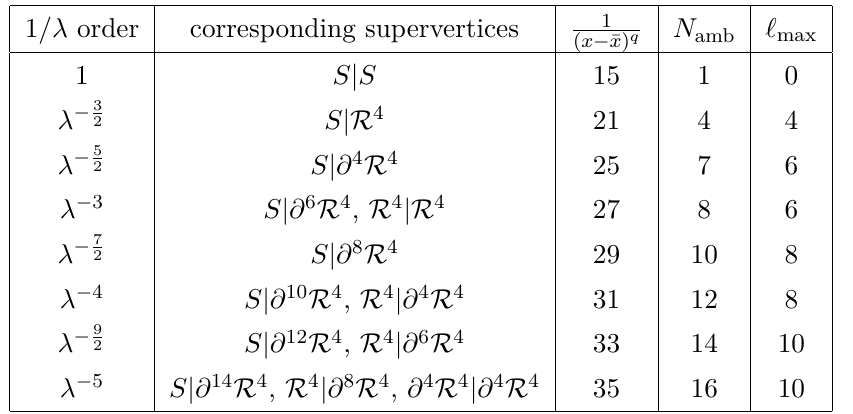
Table 1 . List of one-loop terms in the 1 /λ expansion and their corresponding vertices in the effective string theory action, where S stands for an insertion of the supergravity anomalous dimension. We give the denominator powers q = 2 k +15 of the spacetime functions H (2 ,k ) , the total number of ambi- guities N as well as their maximal spin support ‘ . Note that in general there can be more than amb max one term contributing to the same order in 1 /λ , the first occurrence of this happening at order λ − 3 .